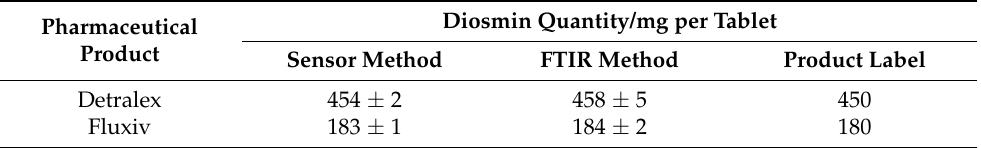
Figure 7. FTIR normalized spectra of Detralex (red line) and Fluxiv (blue line). For diosmin quantification, five solid diosmin-KBr standards of different concentra- tion were prepared, in the range of 100–500 mg/g, and the linear calibration model was performed based on the peak absorbance from 1097.64 cm − 1 . From the peak absorbances at 1097.64 cm − 1 , obtained for the pharmaceutical products, and using the equation of the calibration (A = 0.0031 × c, R 2 = 0.9933), the quantity of diosmin was calculated. The results are presented in Table 5. Table 5. The results of diosmin quantification in the two pharmaceutical products.